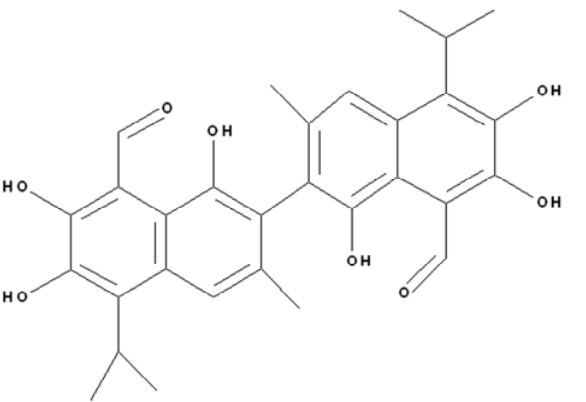
Figure 1. The structure of